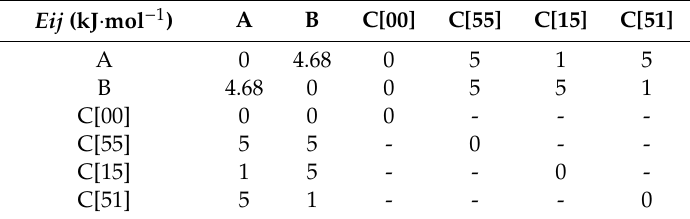
Table 1. Input parameters ( E ij )